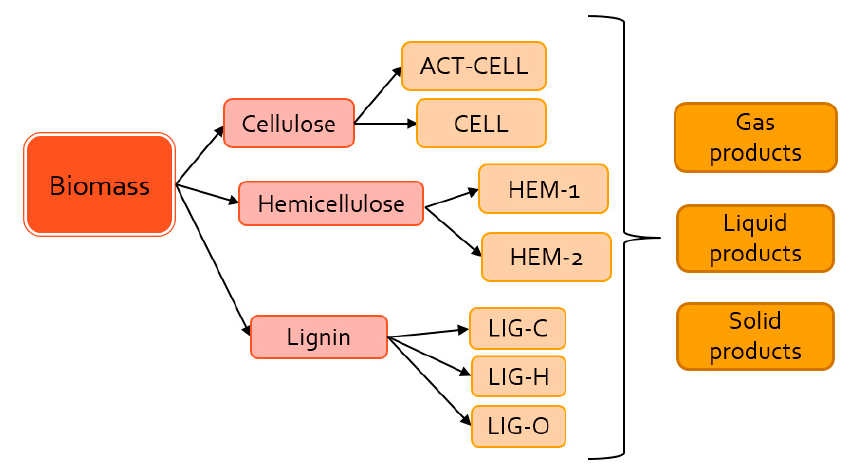
Figure 8. Reaction structure within biomass pyrolysis.